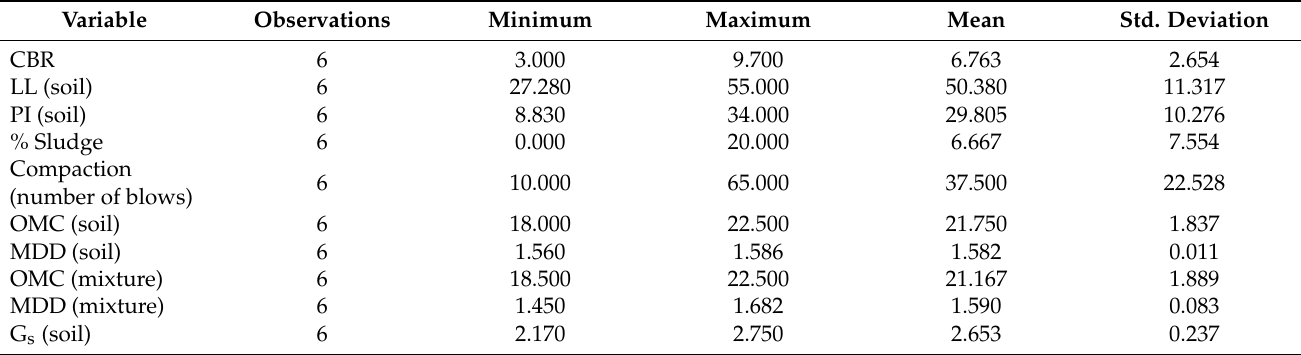
Table 3. The statistical information of the testing